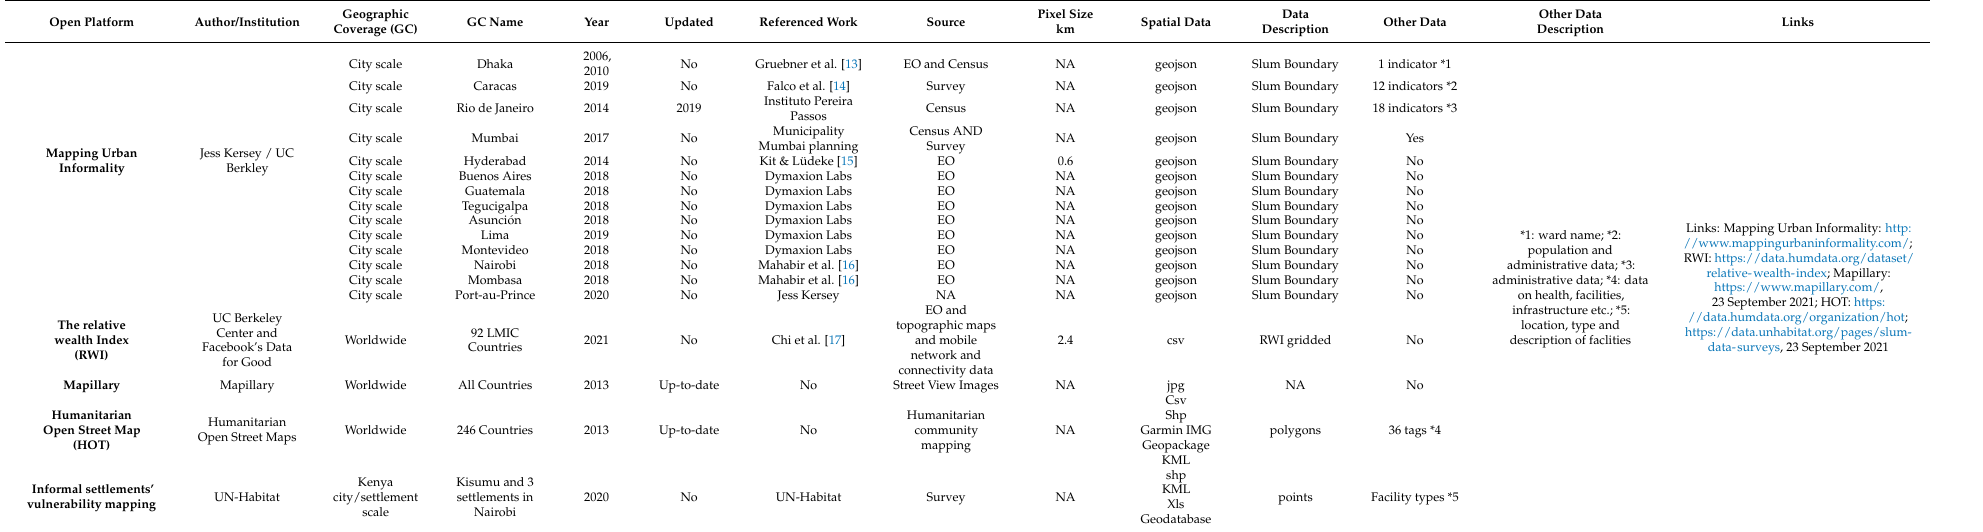
Table 1. Existing open datasets that provide the location and characteristics of deprived urban areas.